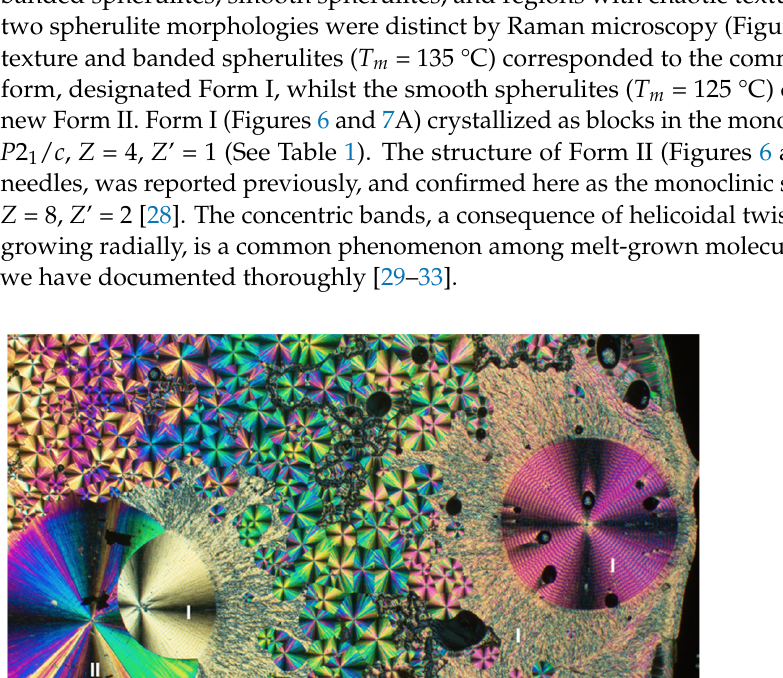
Figure 5. ( A , B ) Single-crystal structures of λ -cyhalothrin Forms I ( A ) and II ( B ). In ( A ), the unit cell contains 8 symmetry-related molecules. In ( B ), the unit cell contains 4 symmetry-related molecules.